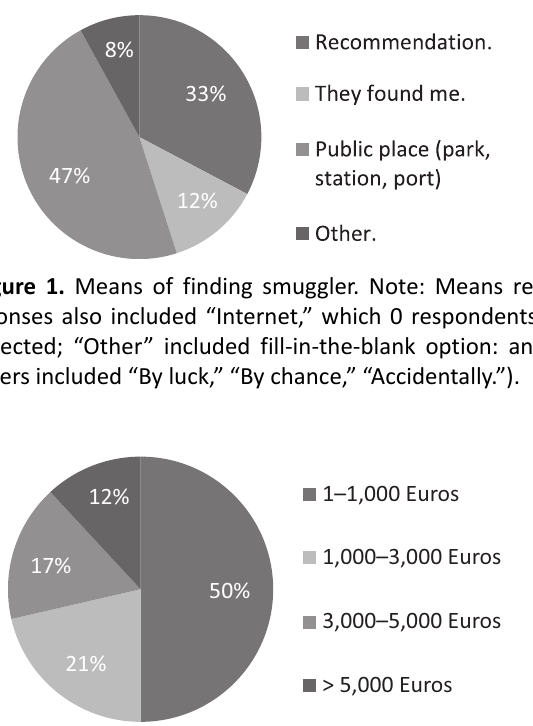
Figure 2. Average smuggling cost per family. Note: Means responses also included “Internet,” which 0 respondents selected; “Other” included fill-in-the- blank option: answers included “By luck,” “By chance,” “Accidentally.”